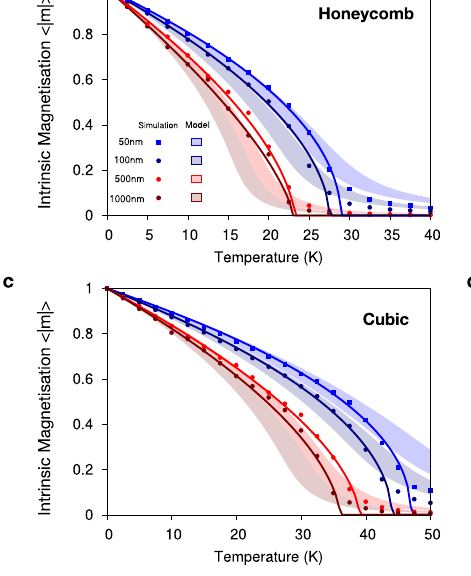
Fig. 2 | Temperature- and size-dependent properties of isotropic 1D and 2D materials with different crystal structures. a – d Comparative simulations of the temperature-dependent magnetisation for honeycomb, hexagonal, square lattices andanatomicchain(1D),respectively,fordifferentsystemsizes.Pointsindicatethe results of Monte Carlo simulations, the lines show fi ts to the Curie-Bloch Eq. (3) in the classicallimit, and the shaded regions indicate the anisotropic sphericalmodel calculations for different assumptions of the renormalisation factor for the Curie